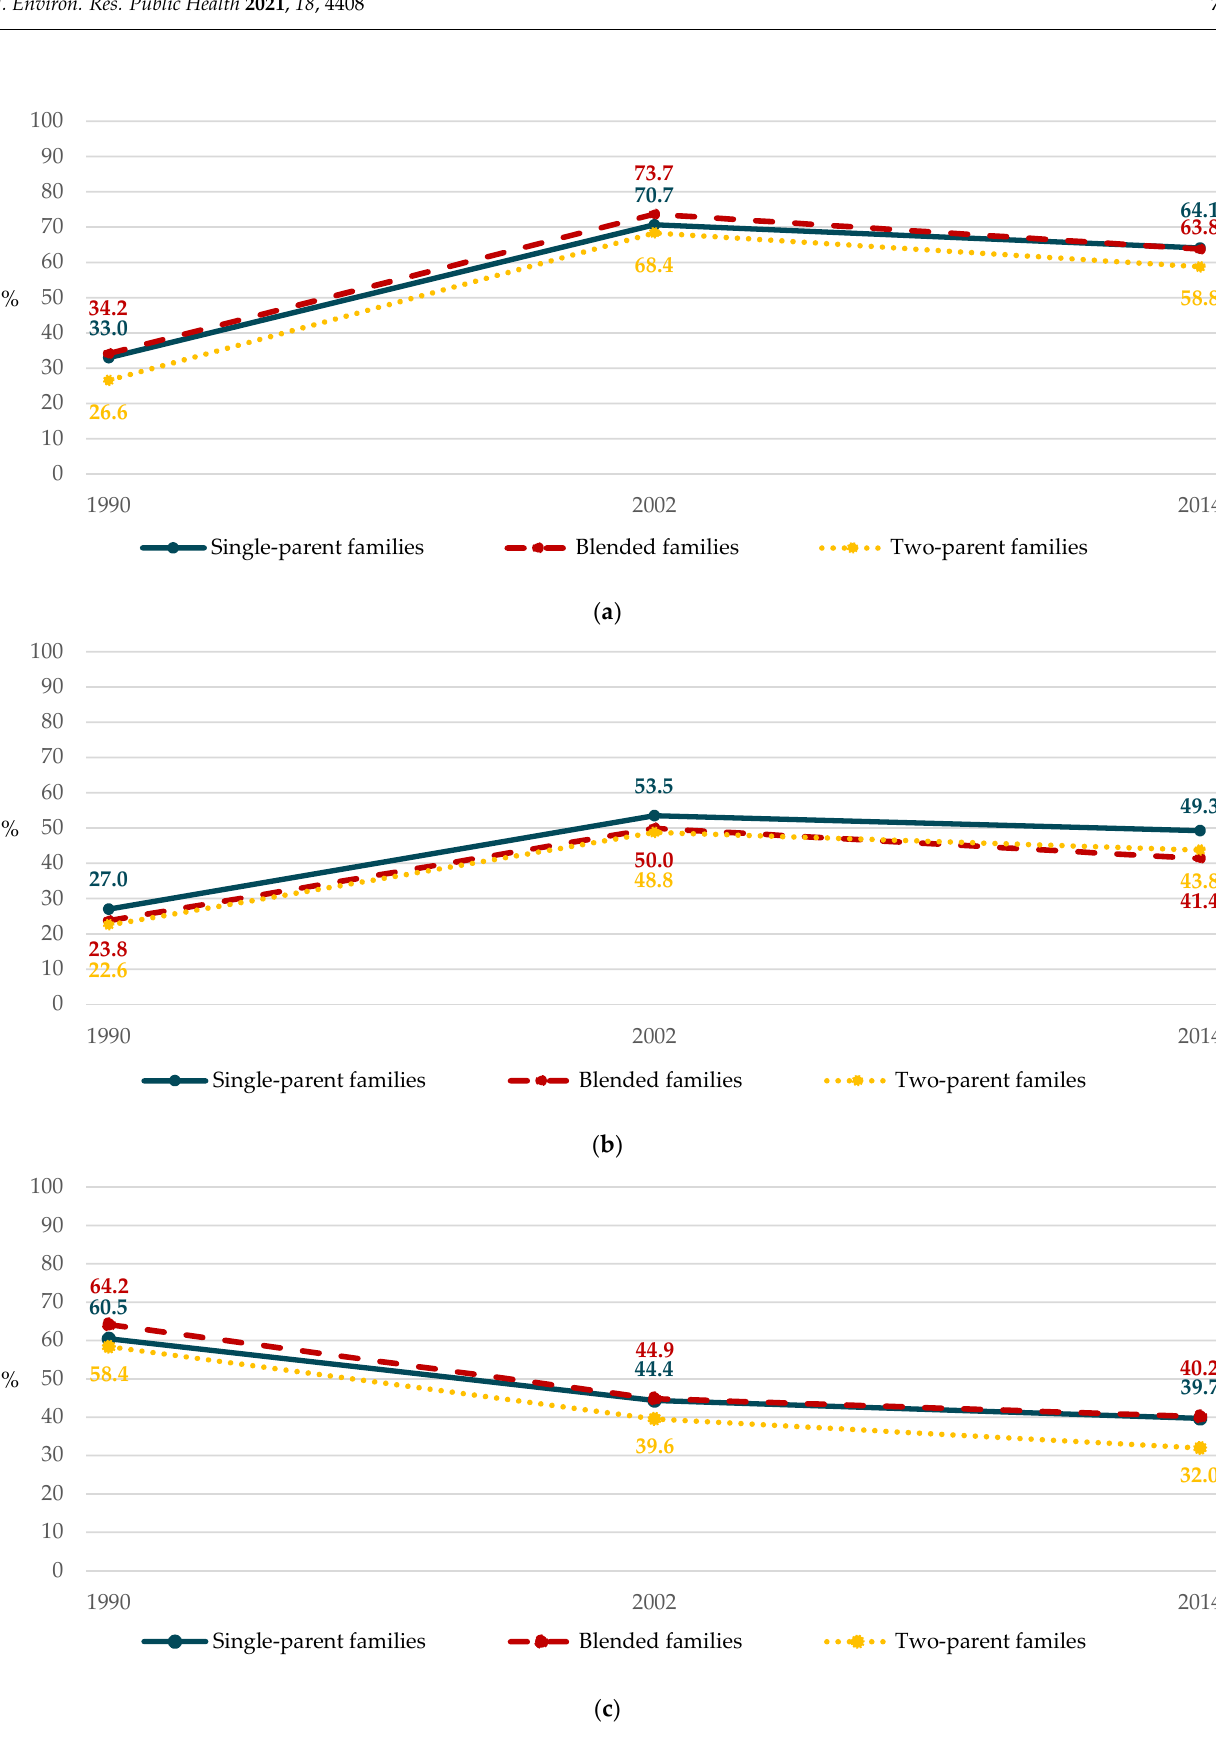
Figure 1. Changes in prevalence of food consumption according to the family structure between 1990 and 2014 (HBSC, Belgium, 1990–2002–2014): ( a ) non-daily fruit; ( b ) non-daily vegetable; ( c ) daily sugar-sweetened beverage.